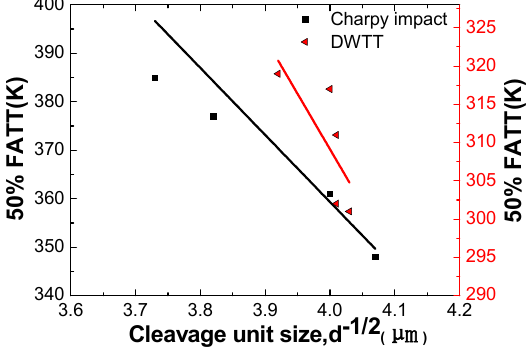
Figure 13. Relationship between cleavage unit size and 50% DBTT (Charpy impact and DWTT).